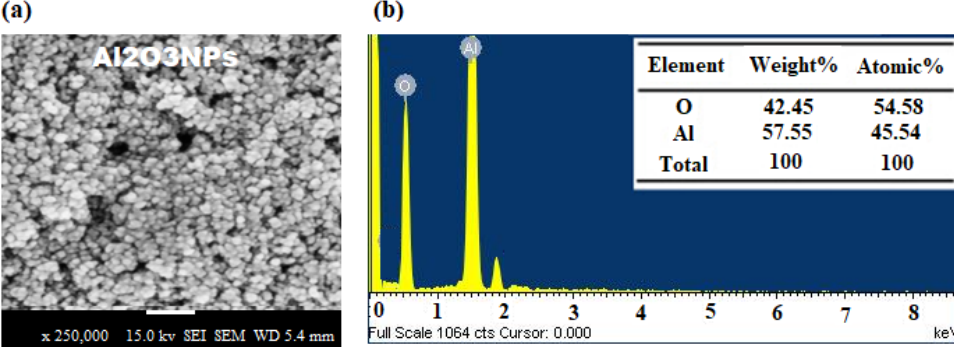
Figure 3. ( a ) SEM and ( b ) EDX images of biosynthesized Al 2 O 3 nanoparticles.